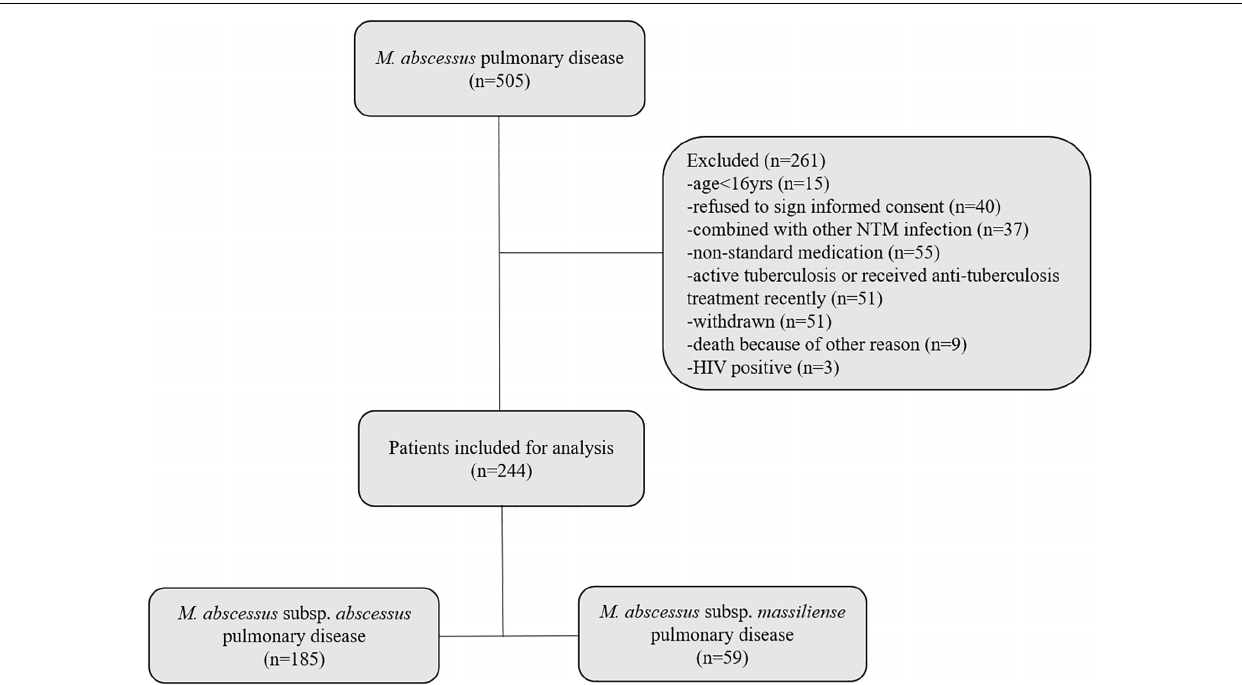
FIGURE 1 | Flow diagram of the study. Two hundred forty-four pulmonary disease patients, who conformed to the inclusion criteria, were enrolled. One hundred eighty-five patients were infected with M. abscessus subsp. abscessus ; 59 patients were infected with M. abscessus subsp. massiliense .